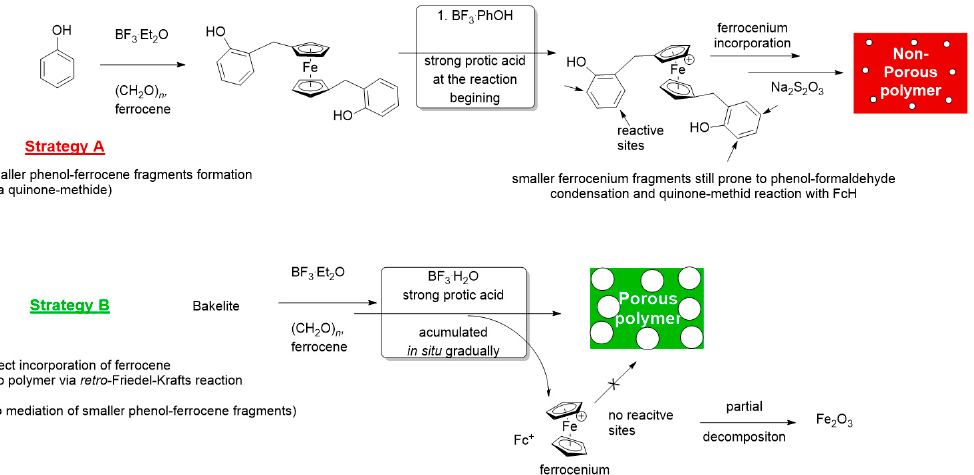
Figure 5. Suggested mechanism for bottom-up polymerization (Strategy A) and insertion into Bakelite (Strategy B).